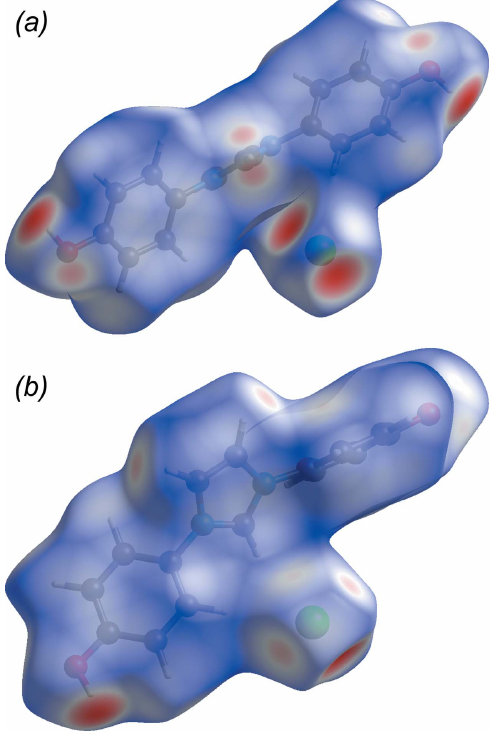
Figure 6 Two views of the normalized contact distances, d norm , mapped onto the Hirshfeld surface of IOH (cid:2) Cl. In ( a ), the larger red regions correspond to the O—H (cid:2)(cid:2)(cid:2) Cl hydrogen bonds, while the smaller pink regions correspond to the C—H (cid:2)(cid:2)(cid:2) O bifurcated weak hydrogen bonds. In ( b ), the faint-pink regions in the upper middle of the diagram correspond to close contacts between imidazole-ring C—H groups and Cl (cid:3) anions.